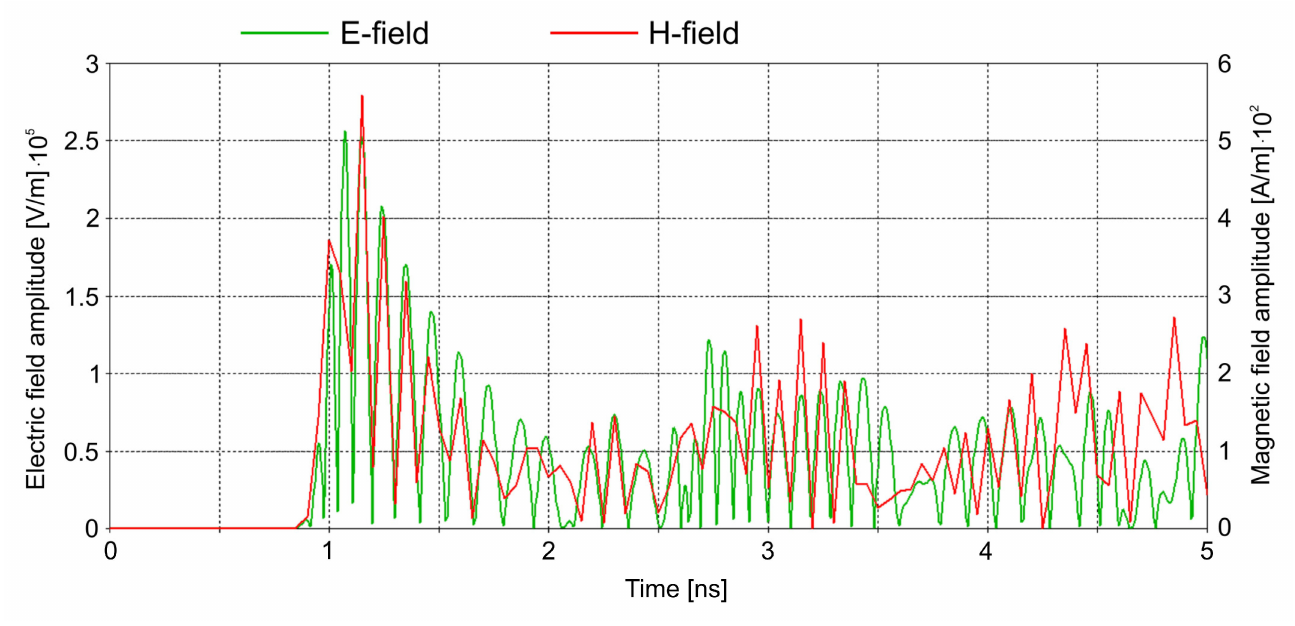
Figure 10. The time dependence of the amplitude of electric (marked in green line) and mag- netic (marked in red line) fields strengths at point A (0,0,0) for parallel polarization of the incident plane-wave pulse of amplitudes 10 6 V/m and 2.68 × 10 3 A/m for the electric and magnetic fields, respectively. The peaks are called the electric and magnetic internal